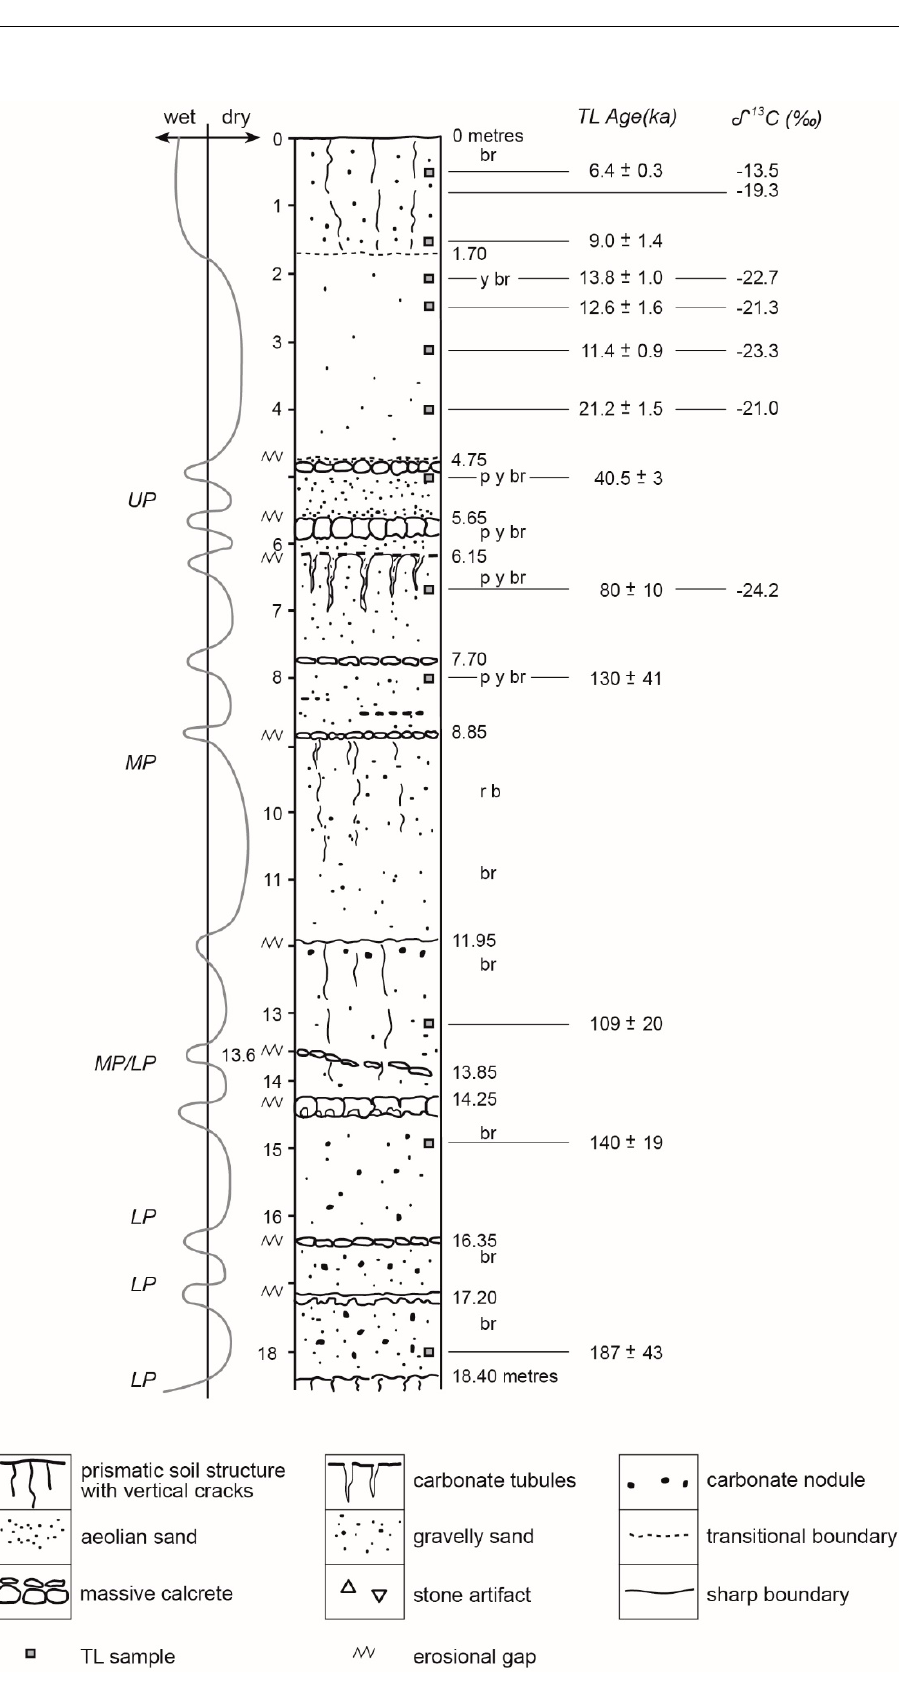
Figure 10. Stratigraphic section through a Quaternary polygenic dune in the Thar Desert, India, showing eleven alternating phases of soil/calcrete formation and sand accretion during the last 200, 000 years. (After [84] Figure 3 and [11] Figure 8.11).